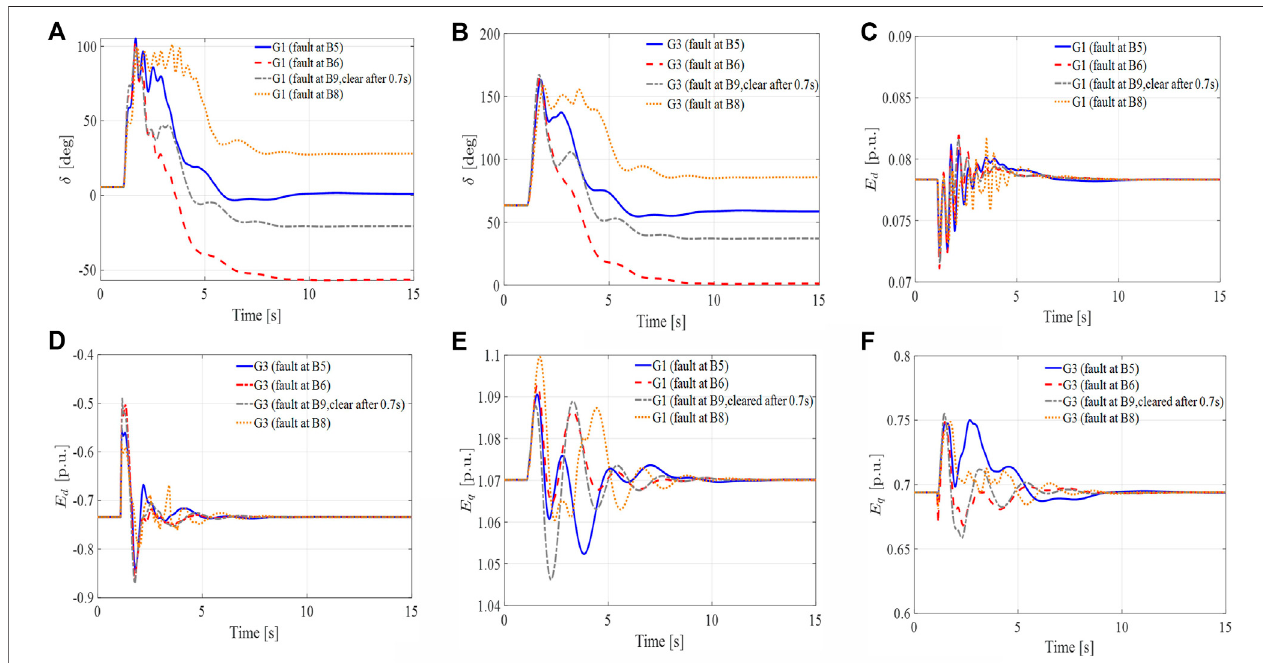
FIGURE 10 | Dynamic responses of the generator and the MMC – MTDC in case 2: (A) The rotor angle of generator 1 in degrees. (B) The rotor angle of generator 3 in degrees. (C) d-axiscomponentofthevoltage1behindtransientreactanceinp.u. (D) d-axiscomponentofthevoltage3behindtransientreactanceinp.u. (E) q-axiscomponentof the voltage 1 behind transient reactance in p.u. (F) q-axis component of the voltage 3 behind transient reactance in p.u. (G) α component of the output-current in MMC2. (H) β component of the output-current in MMC2. (I) Active output power of MMC2. (J) DC Voltage of MTDC system. (K) Voltage of bus 1 in main